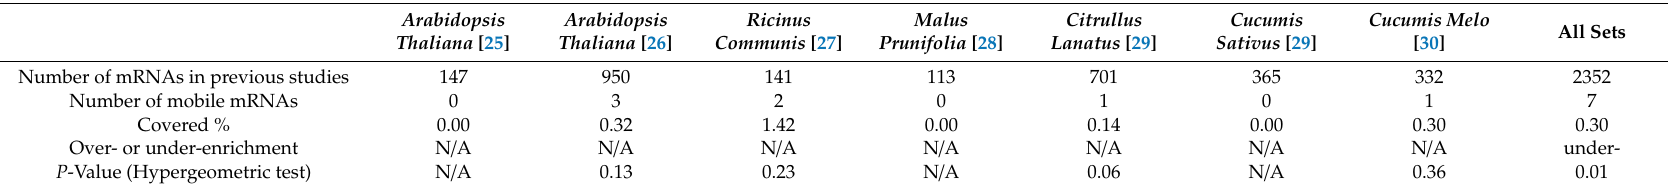
Table 1. Comparison of the 294 mobile mRNAs identified from the N. benthamiana / tomato heterografts in this study with phloem mRNAs identified from previous studies.